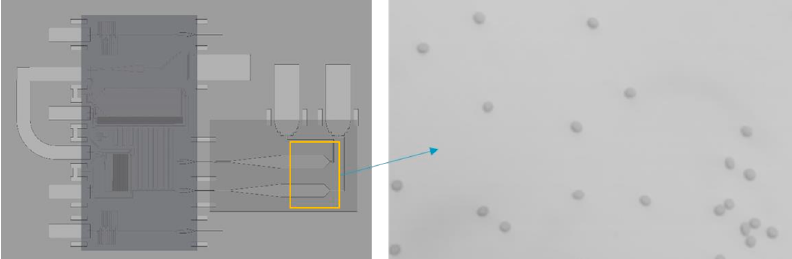
Figure 4. Schematic of the chip with details of the imaging chamber area. Red Blood Cells are clearly visible in the imaging chamber area (zoom on the yellow square).